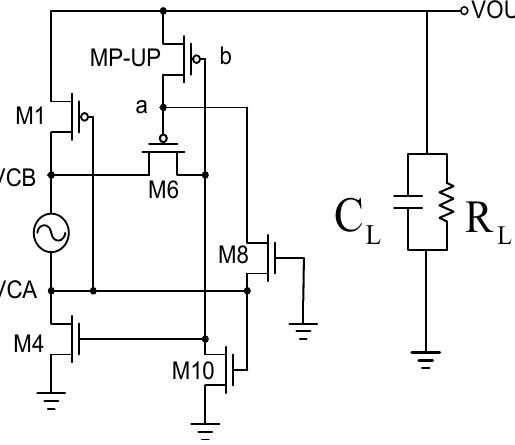
Figure 11. Comparative rectifier equivalent simplified diagram [10].